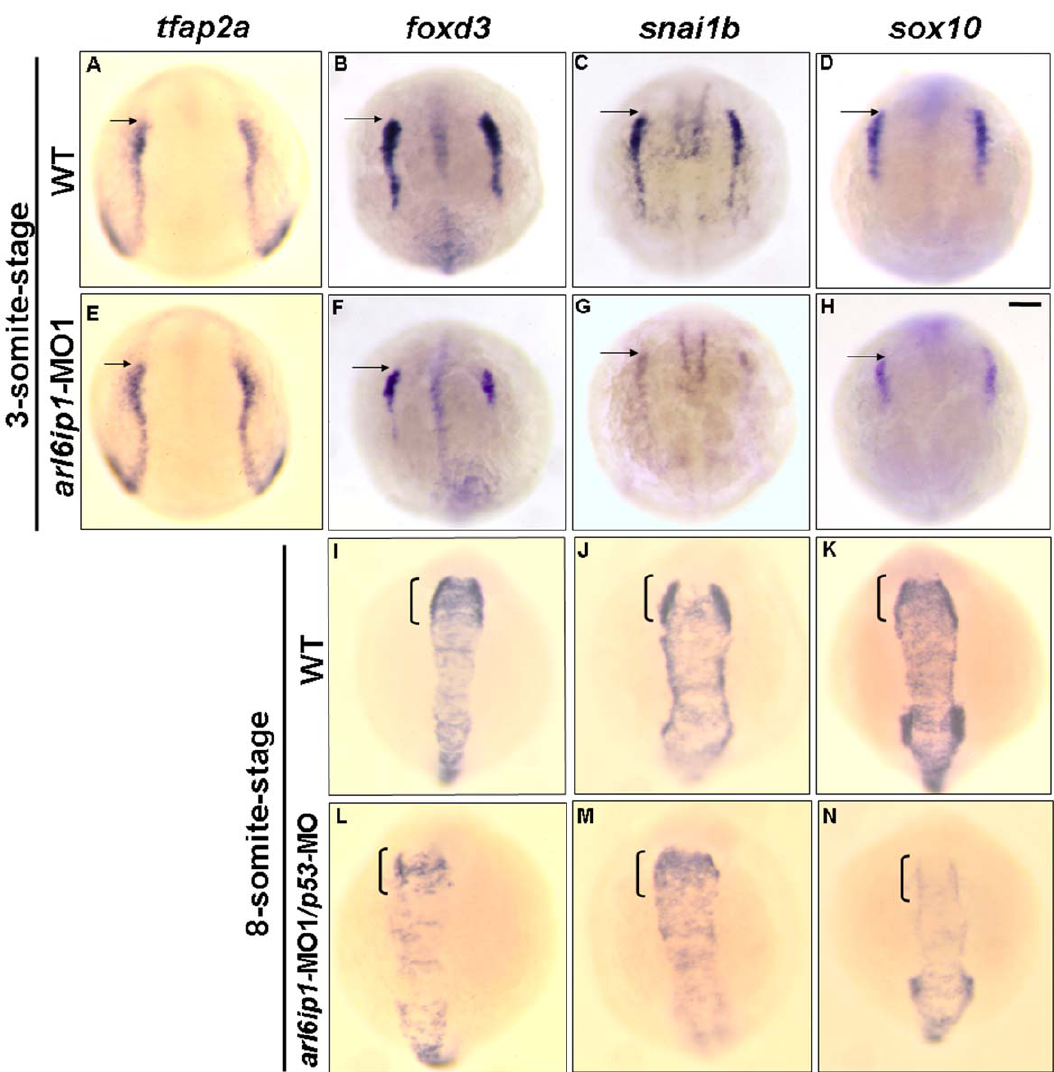
Figure 5. The markers of pre-migratory neural crest cells are down-regulated in arl6ip1 -MO1-injected embryos. Dorsal views of 3- somite-stage wild-type (A, B, C, D) and arl6ip1 knockdown embryos (E, F, G, H), or 8-somite-stage wild-type (I, J, K,) and arl6ip1 knockdown embryos (L, M, N) were shown to reveal the indicated markers. Neural plate border was indicated with the expression of tfap2 a (A, E), foxd3 (B, F), snai1b (C, G) and sox10 (D, H). Decreased expression of these markers, except tfap2 a , was evident and predominant in arl6ip1 morphants. Arrows indicate position of midbrain-hindbrain boundary. (I–K) At the 8-somite stage, these markers were expressed predominantly in early migrating cranial neural crest cells (indicated by brackets). (L–N) These genes were reduced in embryos co-injected with 4 ng arl6ip1 -MO1/6 ng p53 -MO, especially in foxd3 and snai1b expression.